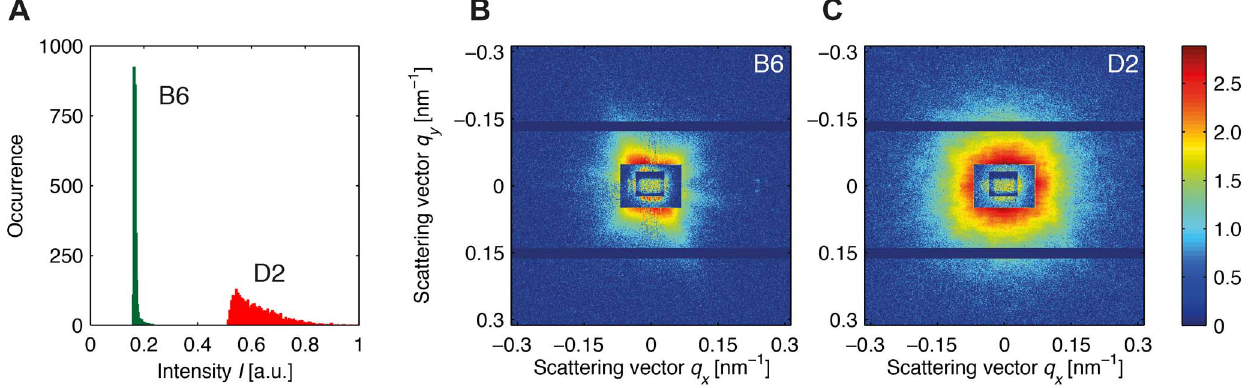
Figure 3. X-ray scattering data for cryogenically prepared melanosomes from C57BL/6J (B6) and DBA/2J (D2) mice. (A) Normalized intensity histograms derived from darkfield STXM maps of B6 and D2 samples like those shown in Fig. 2. The intensity of scatter for the D2 melanosomes is higher and has a broader distribution, than that for the B6 sample. The photon energy was 7.9 keV. (B) Sum of 13 background- corrected scattering events, i.e. hits , for a B6 sample. The scattering pattern is anisotropic. (C) Sum of 13 background-corrected scattering events for a D2 sample. The scattering pattern is isotropic. In (B) and (C), intensity is color-coded on a logarithmic scale. The horizontal bars in (B) and (C), which are devoid of signal, correspond to insensitive regions of the PILATUS, and separate the three detector modules. The artificial look of the regions in the centers is due to the stacking of two semi-transparent beamstops.